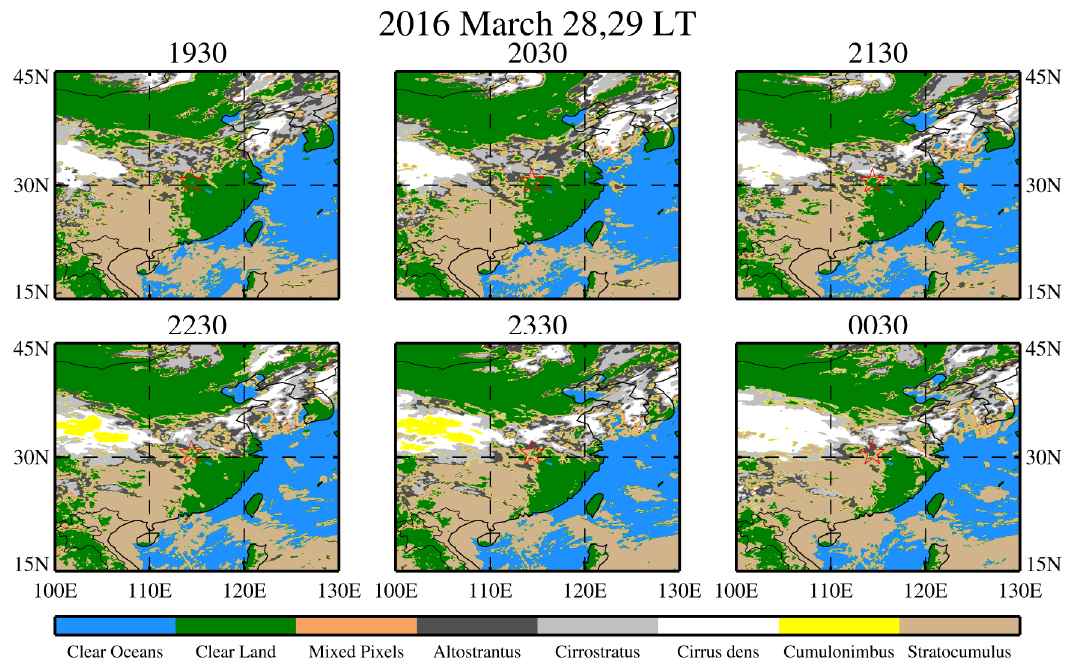
Figure 6. Hourly cloud classification satellite image from the FY-2E geostationary meteorological satellite from 1930 LT on 28 March to 0030 LT on 29 March 2016. The red star denotes the location of Wuhan. Note that stratocumulus covers most of central and western China and spread through Wuhan after 2230 LT.